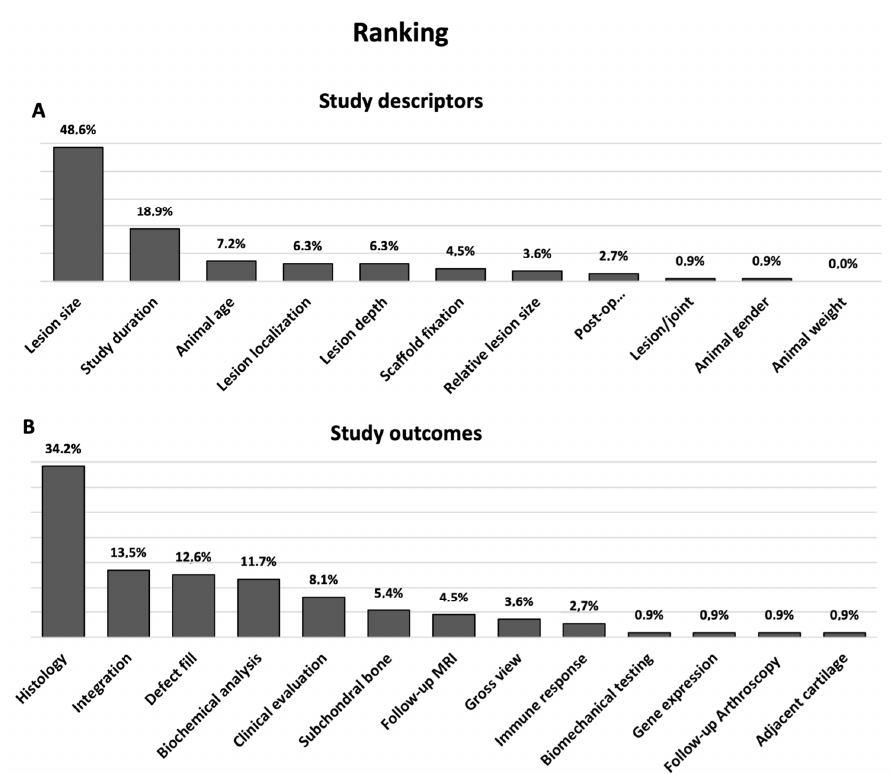
Figure 2. Ranking order of guidance documents criteria. Divided into ( A ) study descriptors and ( B ) study outcomes and arranged according to decreasing importance. The percentage represents the part of participants ranking the respective criteria as most important. n = 37 (participants).